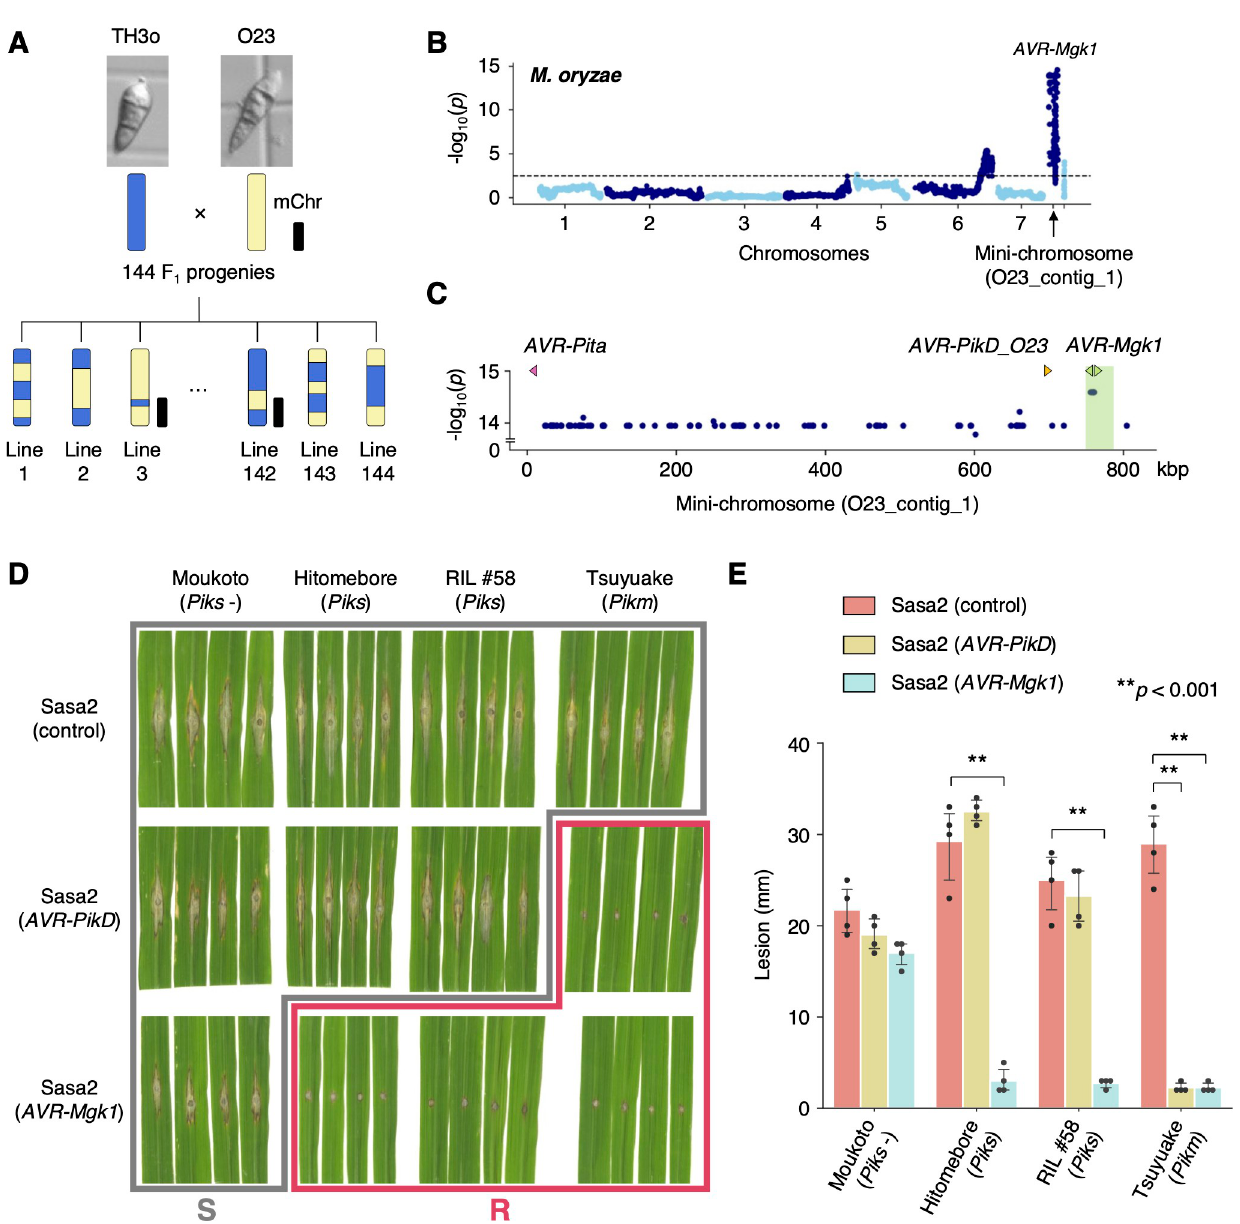
Fig 4. M . oryzae genetic analysis identifies an AVR gene, AVR-Mgk1 , encoded on a mini-chromosome. (A) Schematic representations of the F 1 progeny generated after a cross between M . oryzae isolates TH3o and O23. We subjected all F 1 progeny to whole-genome sequencing. O23 possesses a mini- chromosome [47]. (B) Genetic association of the TH3o × O23 F 1 progeny using infection lesion size on RIL #58 ( Pish -, Piks +) rice plants as a trait. The vertical axis indicates -log 10 ( p ), where the p -value is how likely the marker shows association with a trait due to random chance. The dashed line shows the p -value corresponding to a false discovery rate of 0.05. The association analysis based on the O23 reference genome identified AVR-Mgk1 , encoded on the mini-chromosome sequence O23_contig_1, as an AVR gene. O23_contig_1 was not present in the TH3o genome and was unique to the O23 genome. We used 7,867 SNP markers for chromosomes 1–7 and 265 presence/absence markers for the other contigs. (C) p -values for O23_contig_1 with annotated AVR s. We also detected AVR-Pita and AVR-PikD in O23_contig_1. AVR-PikD in O23_contig_1 contains a frameshift mutation, so we named this variant AVR-PikD_O23 . The region encoding 2 AVR-Mgk1 genes and showing lower p -values is highlighted in green. Nucleotide sequences of the 2 AVR-Mgk1 genes, arranged in a head-to-head orientation, are identical. (D) Results of punch inoculation assays using M . oryzae isolate Sasa2 transformed with AVR-PikD or AVR-Mgk1 . Wild-type Sasa2 infected all the cultivars tested in this study. The Sasa2 transformant expressing AVR-PikD infected RIL #58 ( Piks ), but that expressing AVR-Mgk1 did not infect RIL #58 ( Piks ) or Tsuyuake ( Pikm ) rice plants. (E) Quantification of the lesion size in (D). Asterisks indicate statistically significant differences ( p < 0.001, two-sided Welch’s t test). The data underlying Fig 4B and 4C and 4E can be found in S1 Data . AVR, avirulence; RIL, recombinant inbred line; SNP, single nucleotide polymorphism.